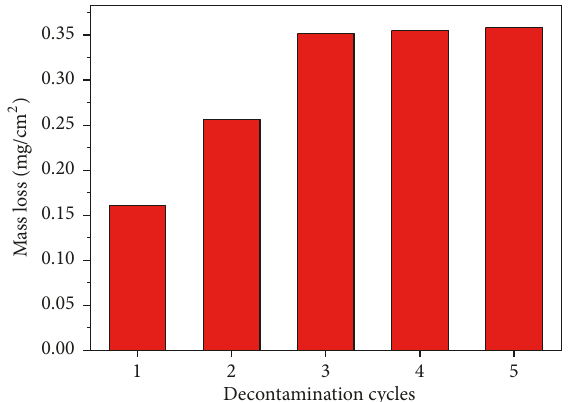
Figure 3: Mass loss of preoxidation 304L SS carrying out AP-N chemical decontamination.